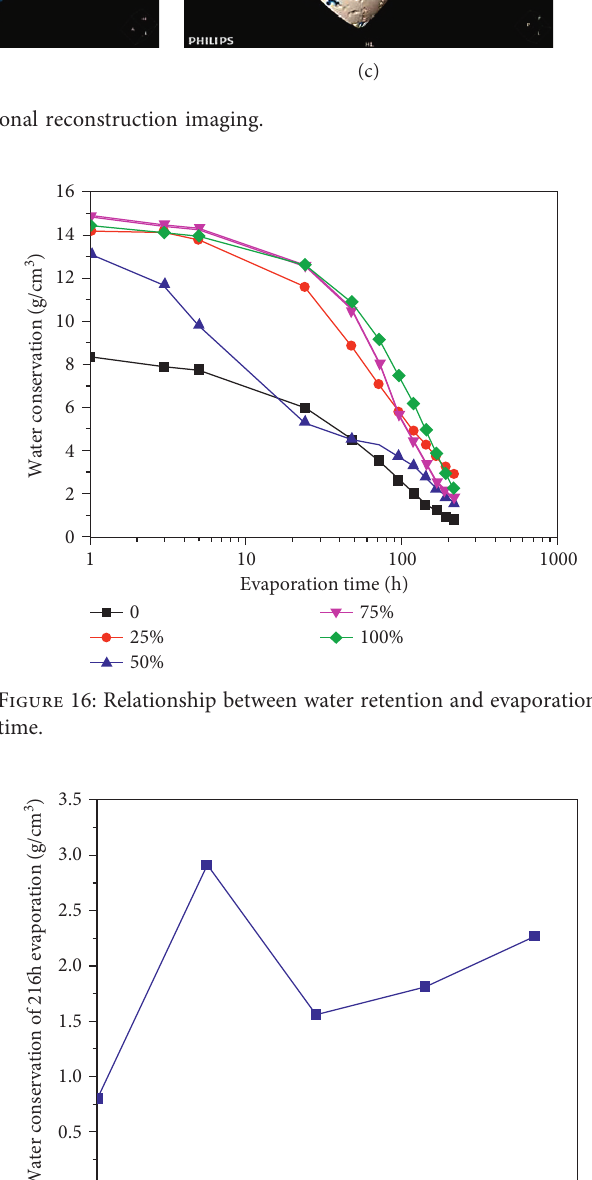
Figure 15: Relationship between the permeability coefficient and RA content.